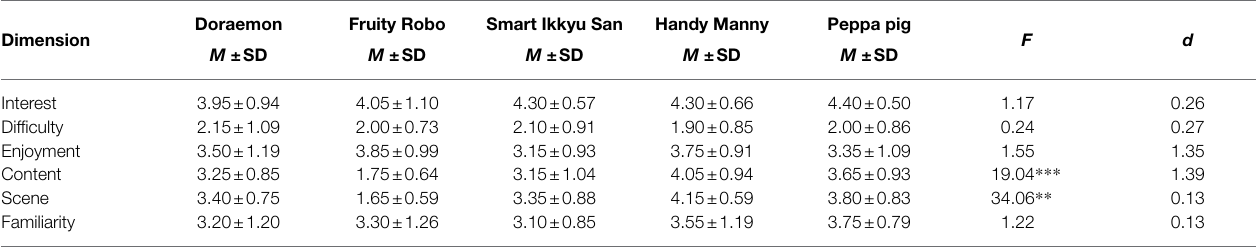
TABLE 1 | Rating results of prosocial attributes of five cartoons ( N = 100). Doraemon Dimension M ±